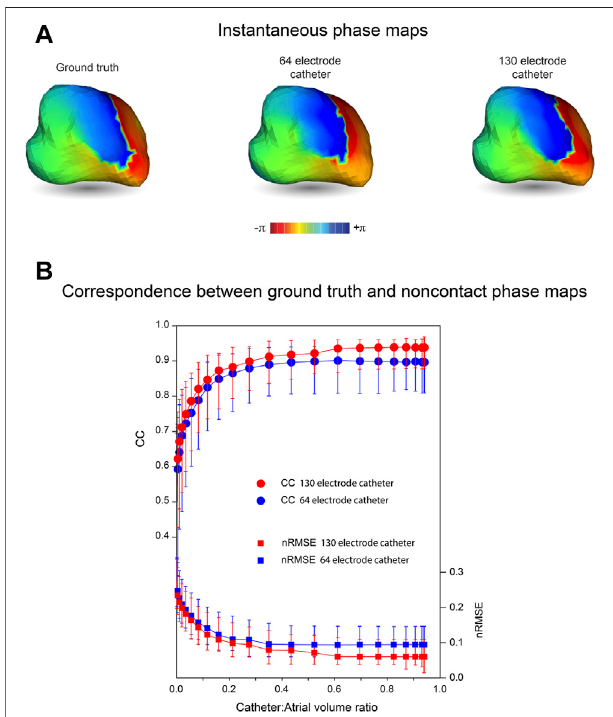
FIGURE 5 | Phase maps of inverse solutions with MFS during macro- reentry. LA surface potentials throughout activation cycle in simulated atrial fl utterarereconstructedfromelectrogramssampledinsidetheLAcavityusing 64- and 130-electrode basket catheters. The centrally located catheters occupy 67% of LA volume. (A) Ground truth phase map at one instant during activation compared with corresponding phase maps for surface potentials reconstructed from electrograms recorded with 64-electrode and 130- electrode basket catheters. (B) CC and nRMSE presented as functions of relativecathetervolumeforthe64-electrodecatheter(blue)and130-electrode catheter (red). Median values and IQR are given. Abbreviations: MFS, Method of Fundamental Solutions; LA, left atrium; CC, correlation coef fi cient; nRMSE, normalized root-mean-squared error; IQR, interquartile